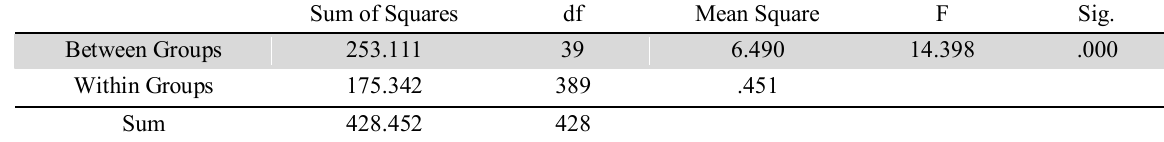
The summary ANOVA test on the effect of age on intellectual assets Sum of Squares df Mean Square F Sig. Between Groups 253.111 Within Groups 175.342 Sum 428.452 428